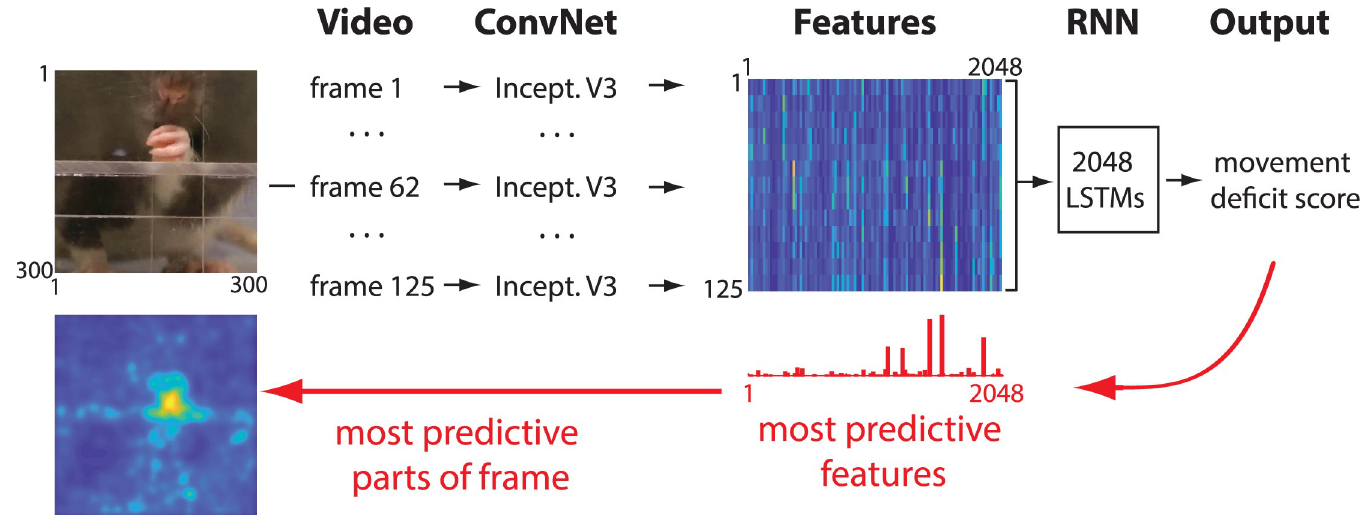
Fig 1. Network architecture. Each frame is first passed through a ConvNet, called Inception V3 (“Incept. V3”), that reduces dimensionality by extracting high-level image features [36]. The features from 125 successive video frames are then given as an input to an RNN. The RNN is composed of LSTM units with the capacity to analyze temporal information across frames. The RNN outputs the movement deficit score for each video. After the network is trained, information is extracted from the network weights in order to identify image features and the parts of each video frame that were most predictive of the network score (red arrows). Network code is available at github.com/hardeepsryait/behaviour_net, and weights of trained model are available at http://people.uleth.ca/~luczak/BehavNet/g04-features.hdf5. See Methods for details. ConvNet, convolutional network; LSTM, long short-term memory; RNN, recurrent neural network.